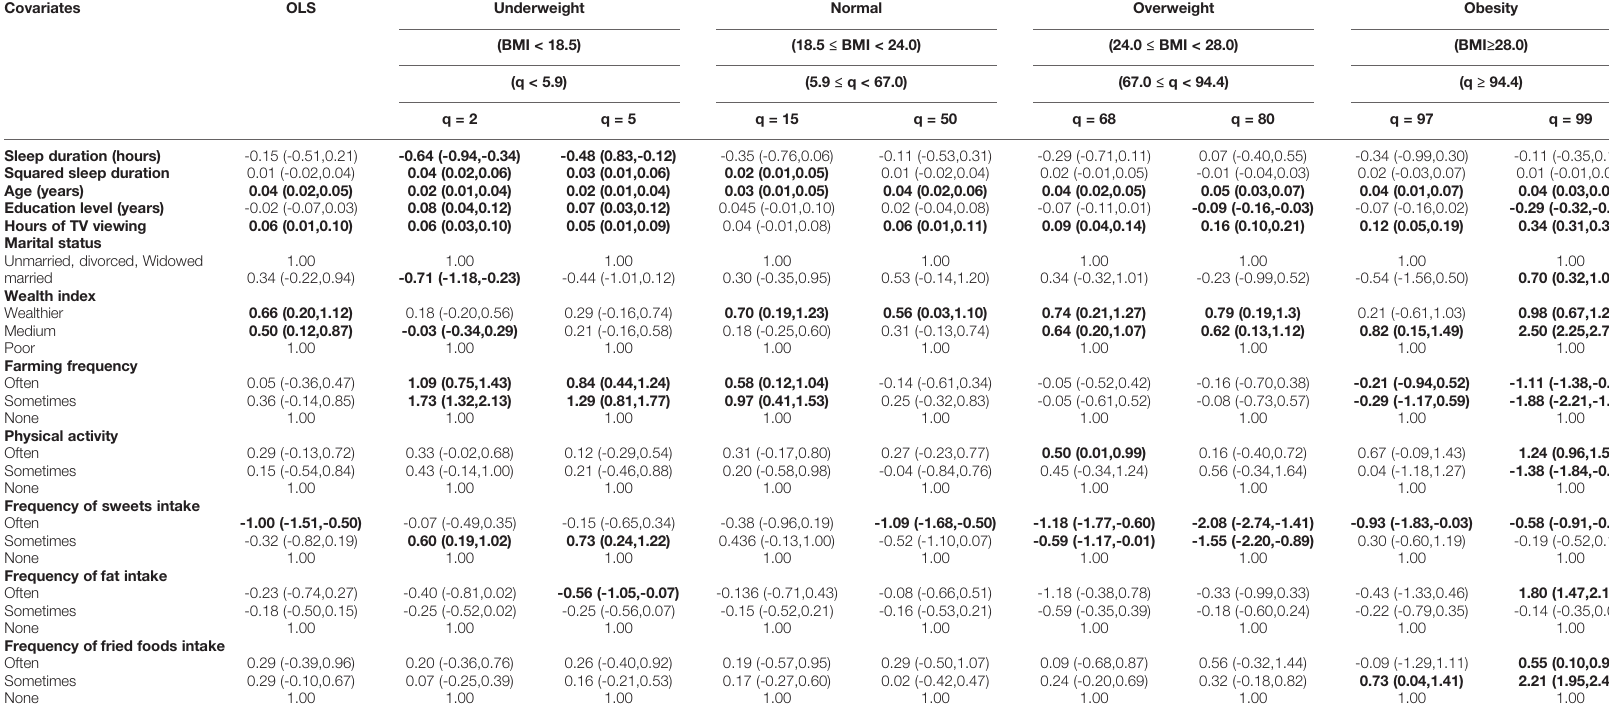
TABLE 3 | The association between sleep duration and the percentiles of BMI among female participants a,b . Covariates OLS Underweight Normal